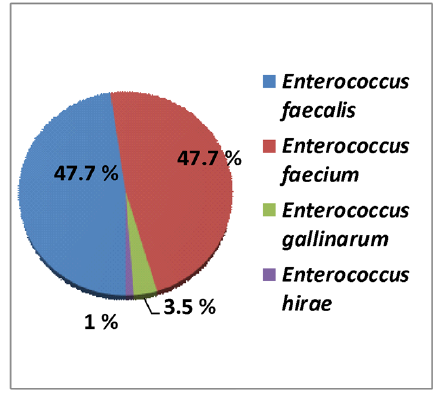
Figure A2. Distribution of types of microorganisms.